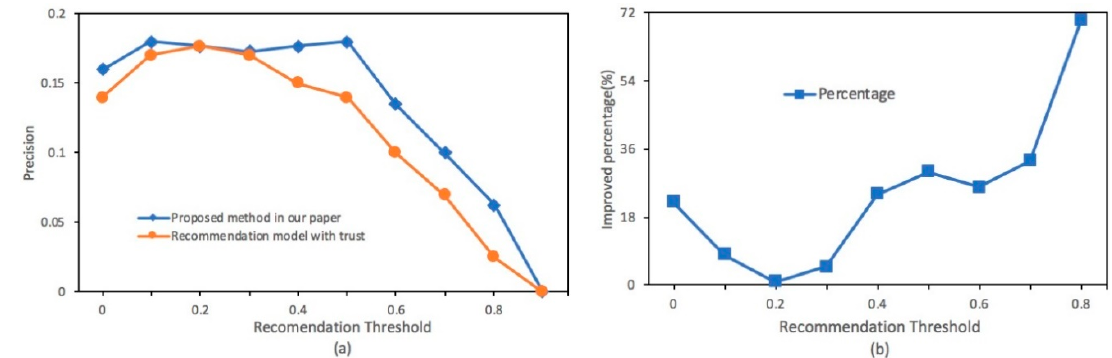
Figure 4. The result of the experiment in the health and personal care shop. ( a ) The results of precision under different recommendation thresholds; ( b ) the percentage of improvement of precision under different recommendation thresholds.